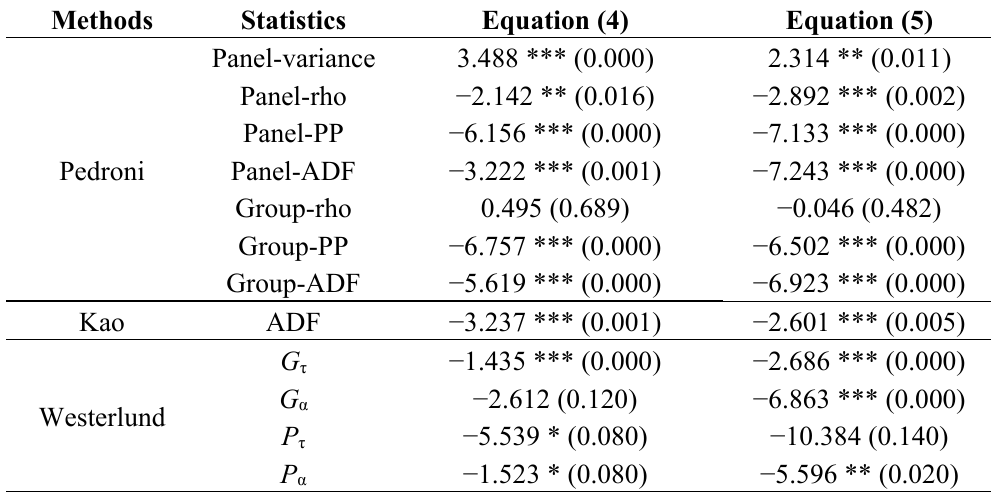
Table 4. Panel cointegration tests.